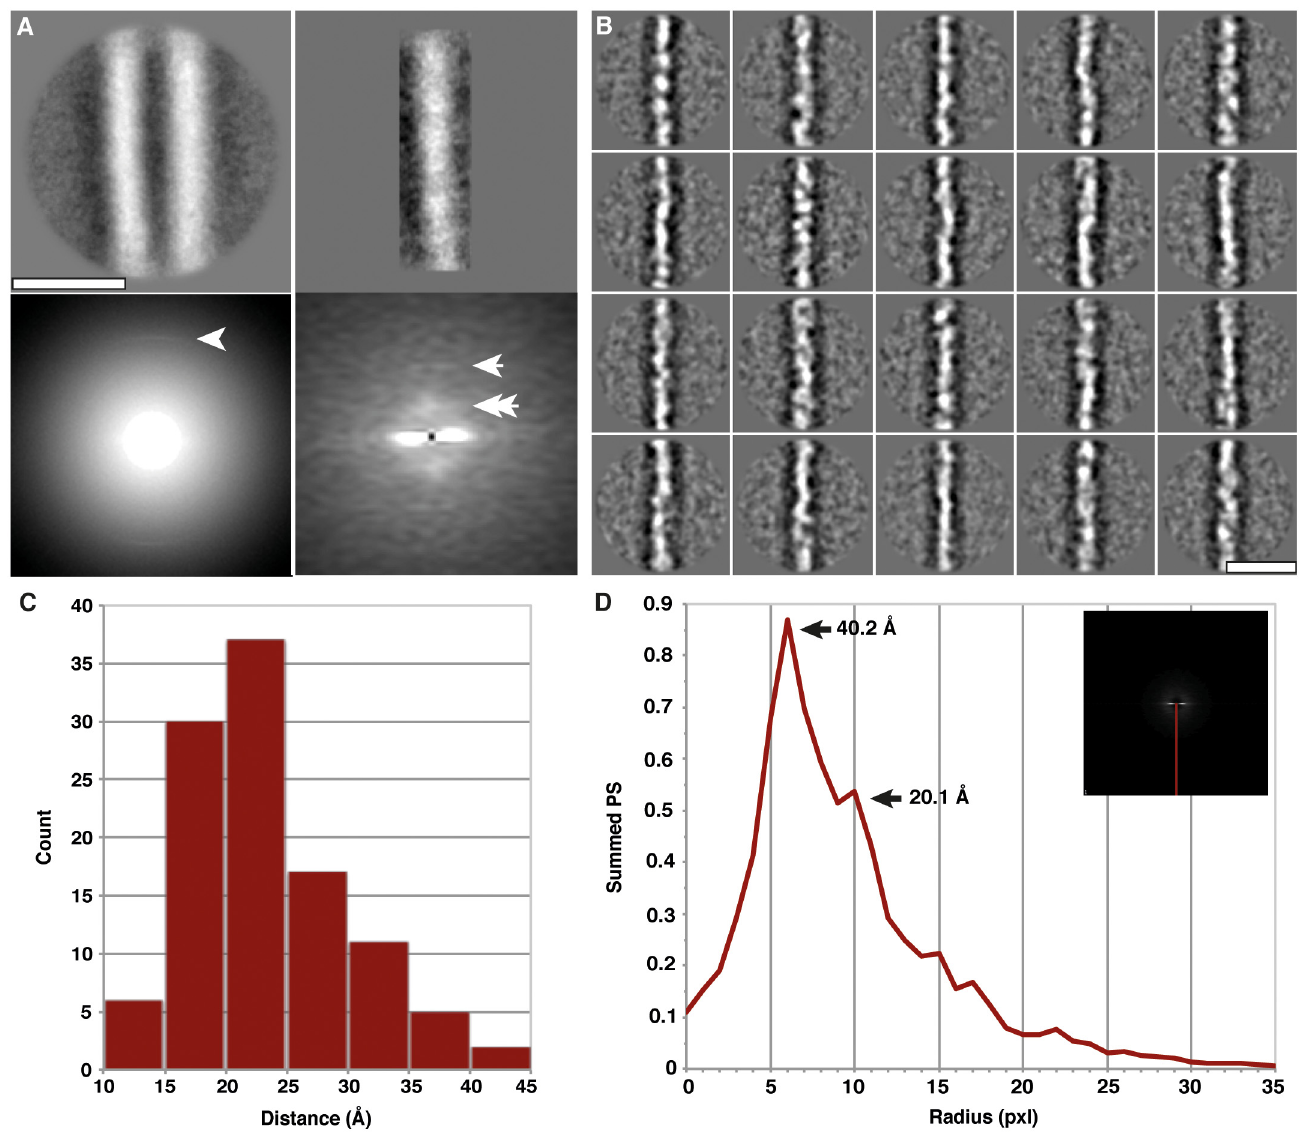
Fig 5. Single particle averaging of GPI-anchorless PrP 27 – 30 fibril images. ( A ) Average from 1072 fibril segments (top left) and the logarithm of their summed power spectrum (bottom left). The arrowhead indicates the characteristic 4.8 Å cross- β signal. Representative 2D class average of 100 single protofilaments (top right) and their averaged Fourier-transform (bottom right). Single and double arrows are pointing to intensities at 19.1 Å (single pixel) and ~40 Å (38.3 Å and 44.6 Å pixels), respectively. ( B ) Gallery of 2D class averages obtained from reference-free analysis of individual protofilaments. Box size is 150 by 150 pixels, equivalent to 20.1 by 20.1 nm. ( C ) Histogram of manually determined sizes of densities along the protofilament from the class averages in (B). The majority of densities fall into the classes between 15 and 25 Å . ( D ) The average over all amplitude spectra of all class averages. A plot of the meridian of the Fourier-transform (red line) reveals a broad peak around 40.2 Å and a smaller peak at 20.1 Å (arrows). The Nyquist frequency (2.68 Å ) corresponds with the 75 pixel outer border of the spectra. Scale bars, 10 nm.